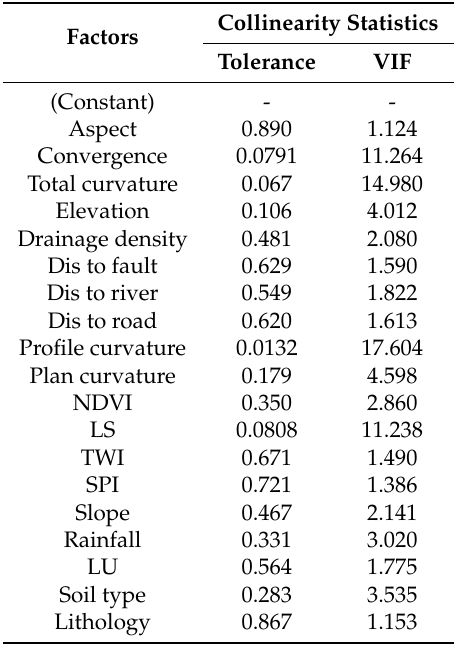
Table 2. Multicollinearity test among conditioning